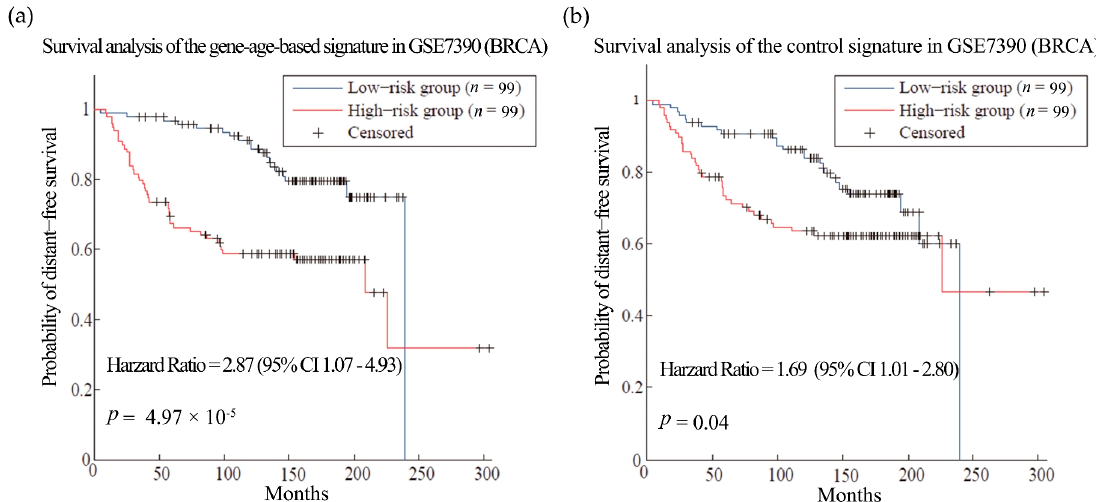
Figure 3. Survival analysis of the breast cancer dataset GSE7390. ( a ) and ( b ) are the predictions of the BRCA prognosis model using gene-age-based signatures and control signatures in independent test sets GSE7390 separately.